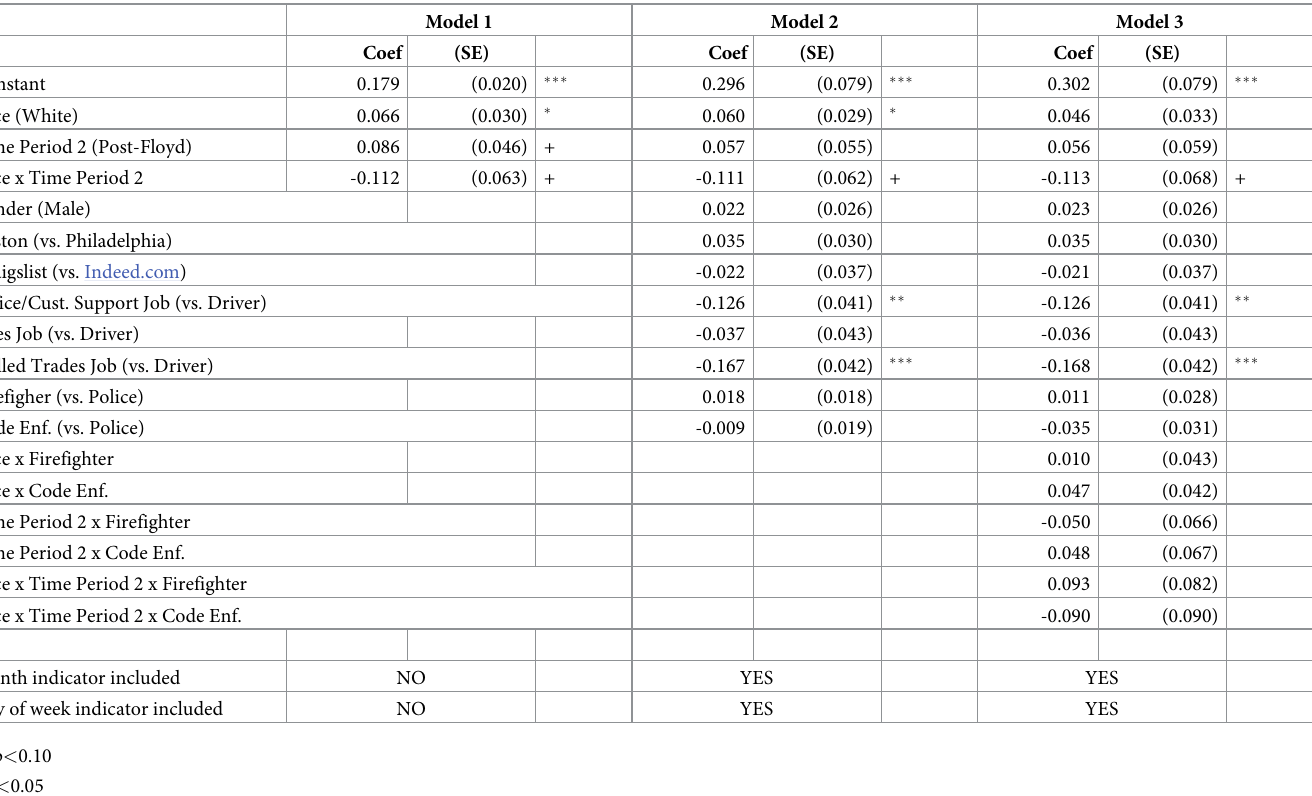
Table 2. Linear probability models of employer responsiveness to job applications, by time period and applicant